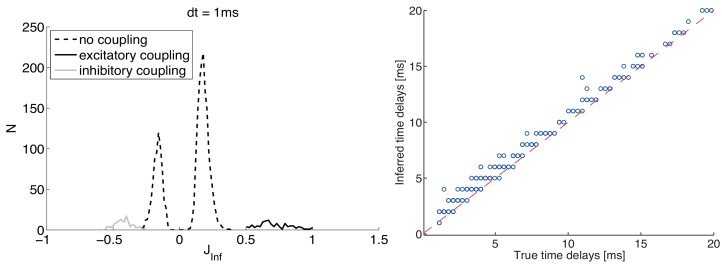
Inference results for the Kinetic Ising Model with time delays for a network of excitatory and inhibitory neurons (same parameters as in Fig. 3), obtained with time-bin dt = 1 ms.Left panel: histograms of inferred synaptic couplings, for excitatory (black solid line) and inhibitory (grey solid line) synaptic contacts, and for those corresponding to unconnected pairs (dashed line). Right panel: delays inferred from the cross-correlation peaks vs actual delays for existing synapses; the dashed line marks the identity line. Neurons fire at about 50 Hz; the total recording length is 500 s.